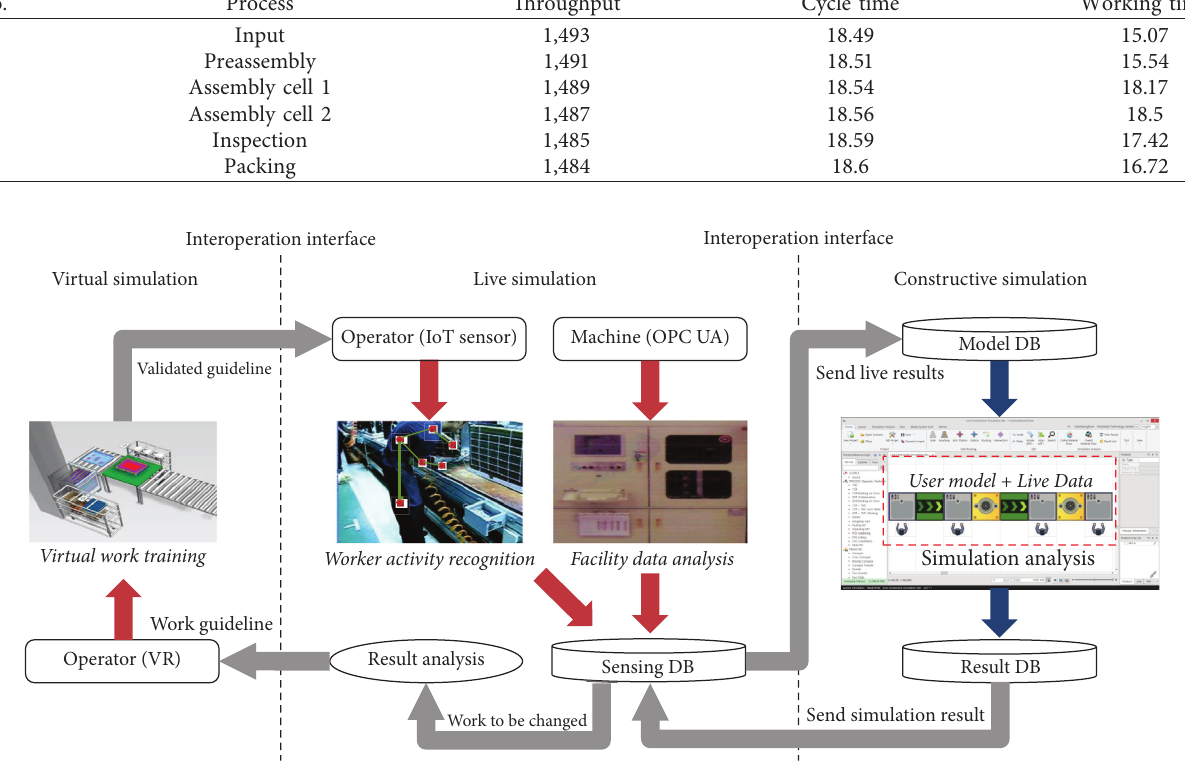
Figure 15: The LVC interoperation procedure performed in the case study.